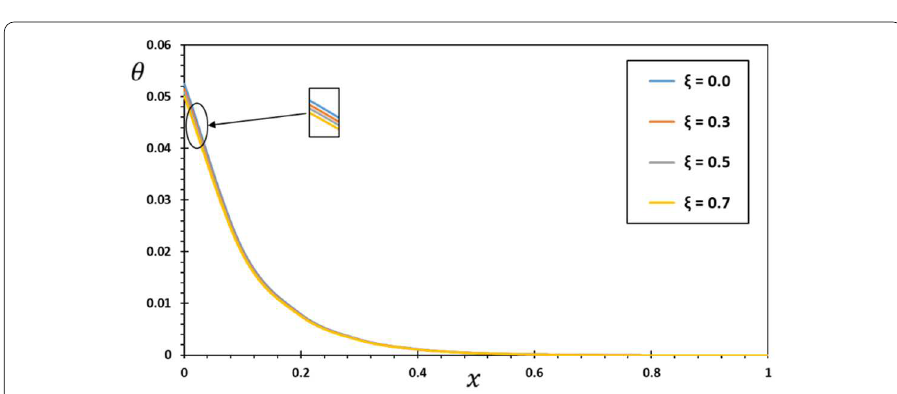
Figure 7 The effect of nonlocality ( ξ ) on the variation of the temperature θ